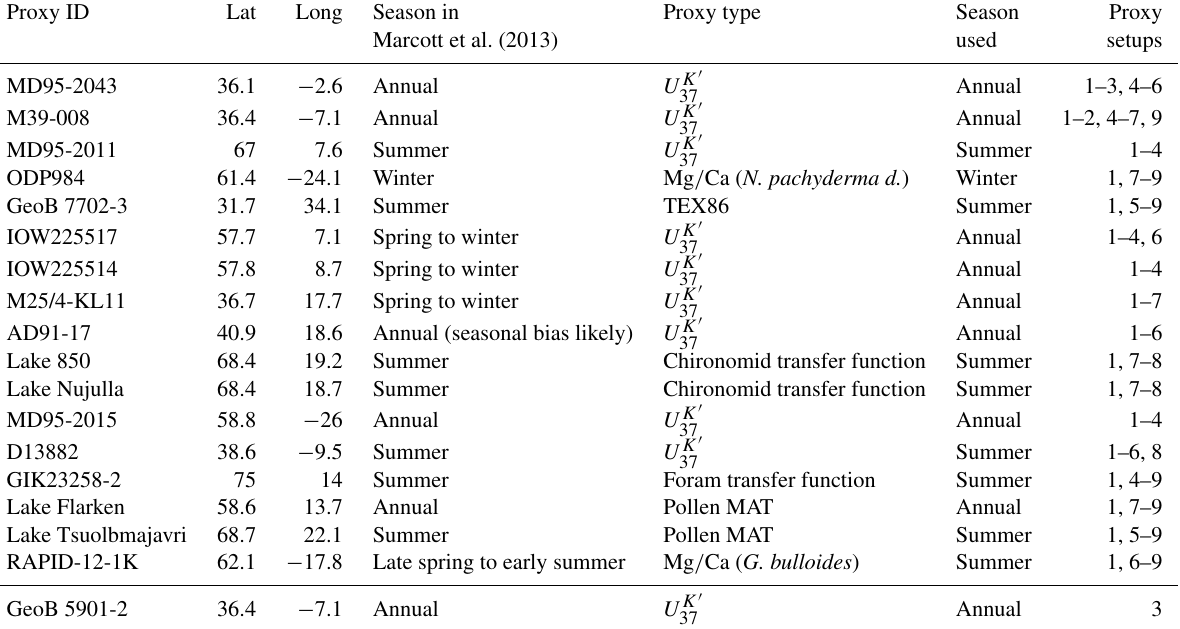
Table 1. Information about the considered proxy records: IDs, geographical location, seasonal attribution according to Marcott et al. (2013), proxy type, seasonal attribution used here, and analogue search setups that use the record. All proxy data are from the Supplement of Marcott et al. (2013). Table A1 provides references to original publications and datasets. Proxy setups refer to those analogue search tests where this proxy is included (compare also Fig.